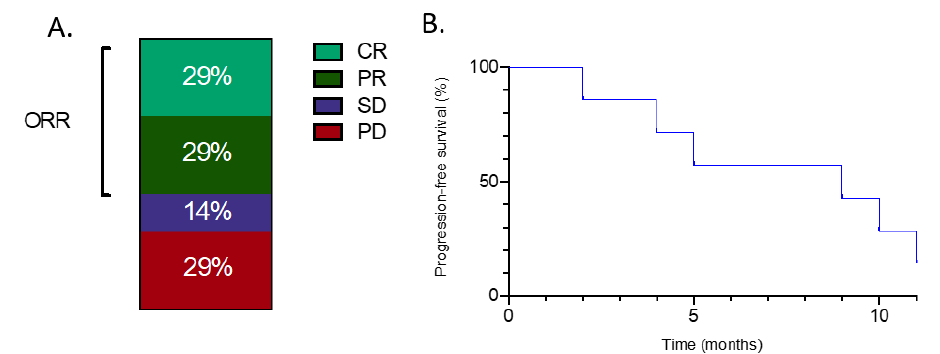
Figure 1. ( A ) Objective response rates with gemcitabine-containing regimens for patients with metastatic myxofibrosarcoma treated in the second-line setting. ORR: Objective response rate. PD; progressive disease. CR; complete response SD; Stable disease PR; Partial response. ( B ) Progression-free survival with gemcitabine-containing regimens for patients with metastatic myxofibrosarcoma treated in the second-line setting. Table 1. Baseline characteristics.